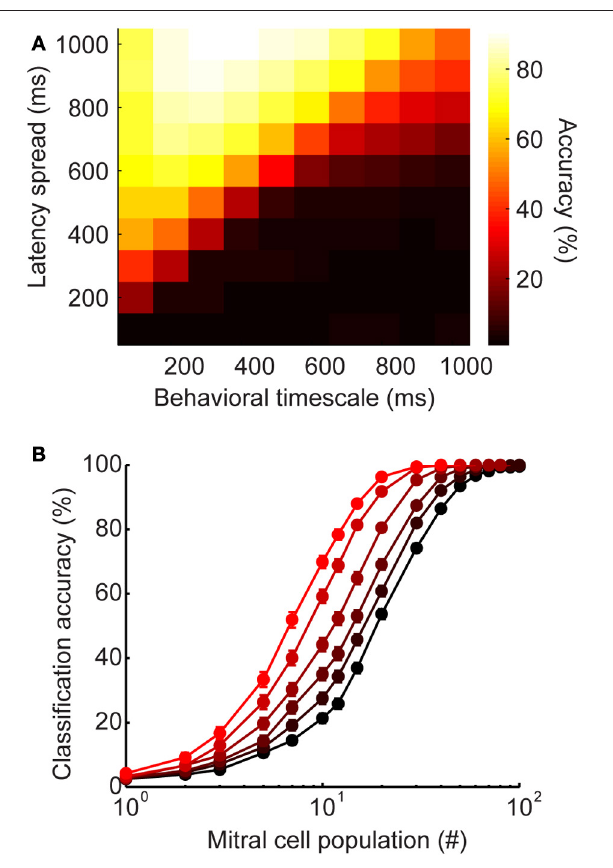
FIGURE 6 | Latency-induced improvements are robust to changes in parameters and stimulus generation. (A) Heatmap of classification accuracy for varying ranges of latency spread at different behavioral time points. (B) Alternate stimulus generation. Each stimulus has a stimulus-specific latency pattern (as seen in Figure 5 ), as well as a stimulus-specific subset of active interneurons. Here, each stimulus recruits only 50% of model granule cells. Classification accuracy as a function of mitral cell population size. Colors correspond to latency ranges in Figure 5 (200, 400, 500, 600, 800,